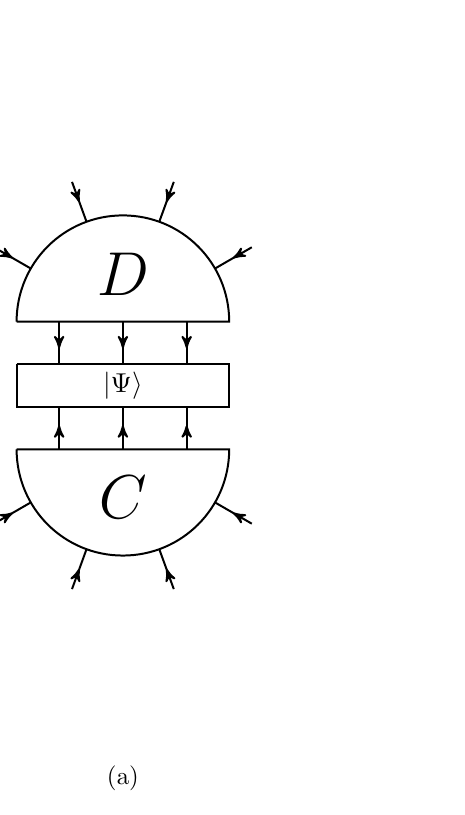
Figure 7. (a) Graphical description of (2.18), which gives a tensor network state in terms of the two block tensors C and D defined by a cut γ . (b) Graphical description of eq. (2.19), which computes the state on a cut γ